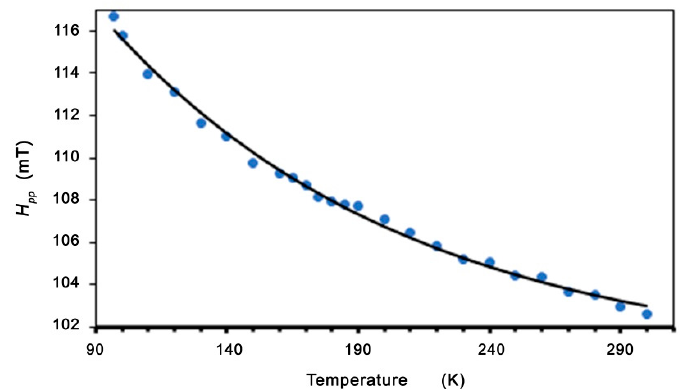
Figure 7. Temperature dependence of the peak-to-peak linewidth for Zn 0.8 Co 0.2 O/Ag. Theoretical line fitted based on Equation (2).